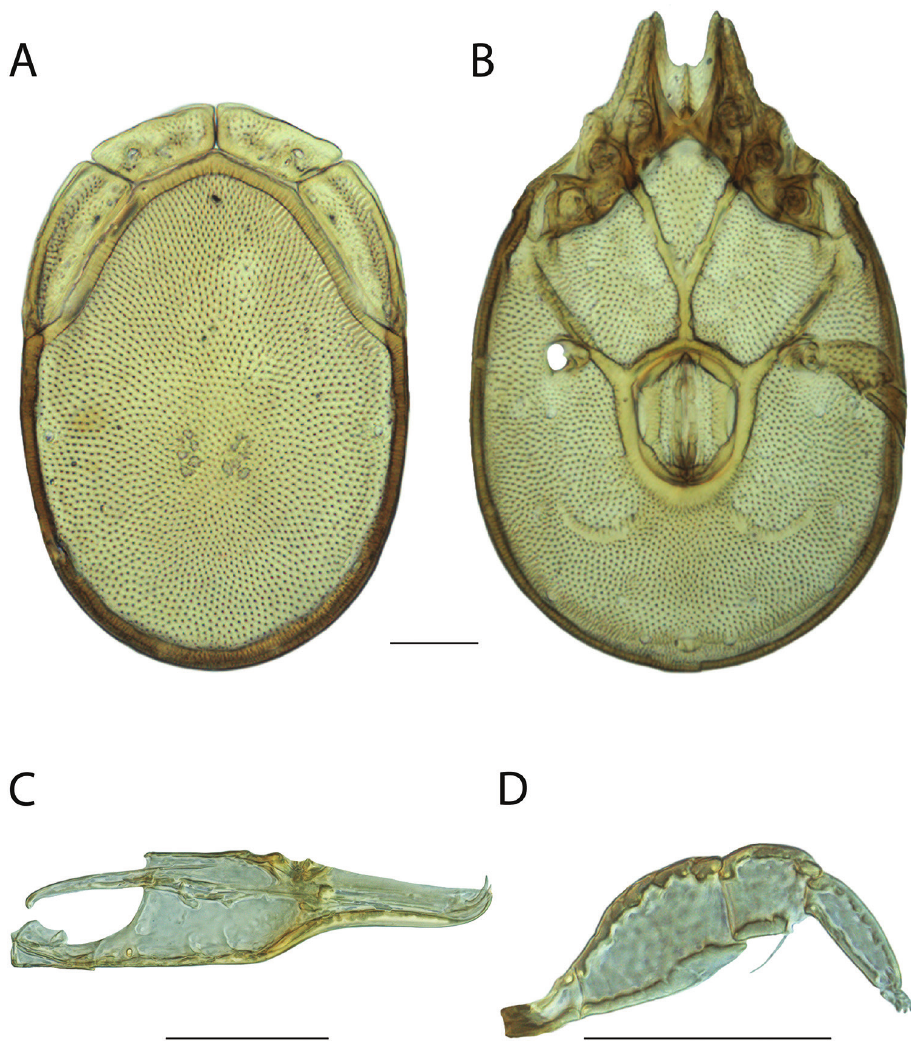
Figure 20. Torrenticola anoplopalpa sp. n. male: A dorsal plates B venter (legs removed) C subcapitulum D pedipalp (setae not accurately depicted). Scale = 100